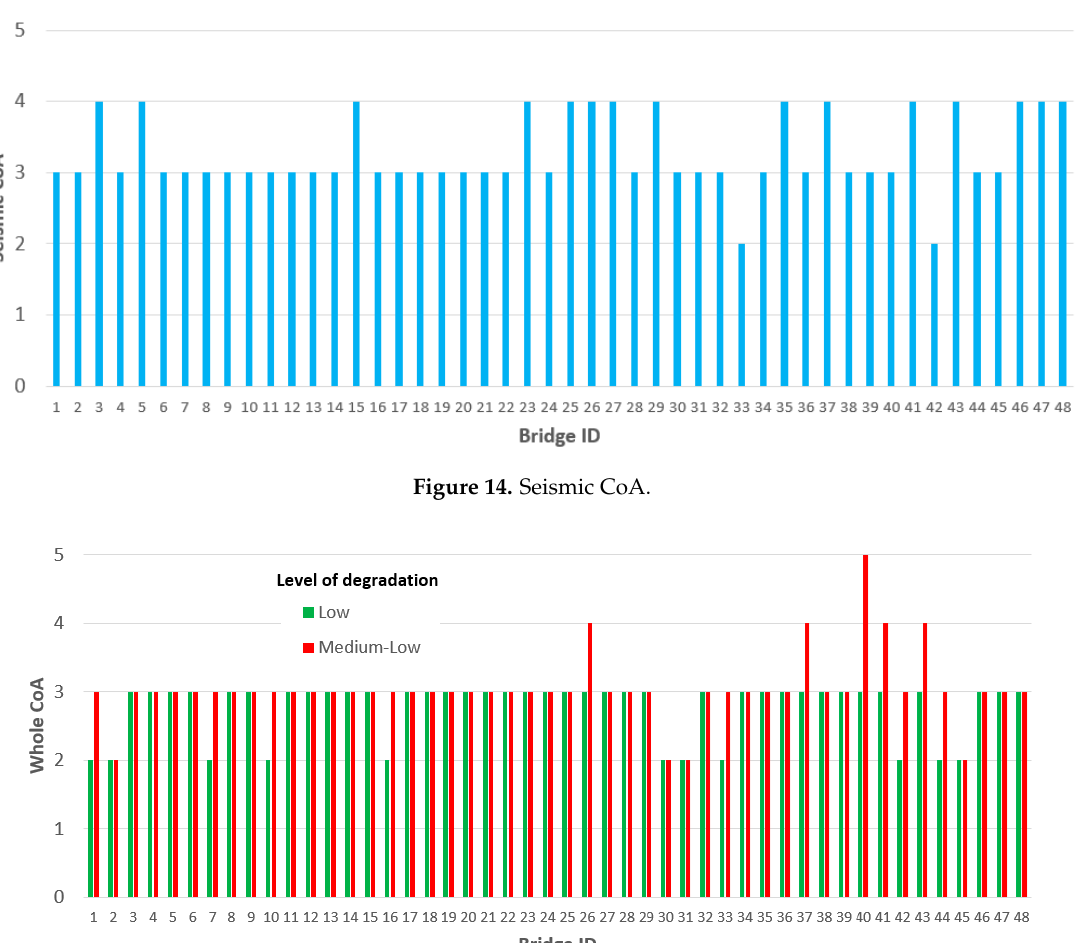
Table 6. Overall CoA result as a function of the level of degradation.